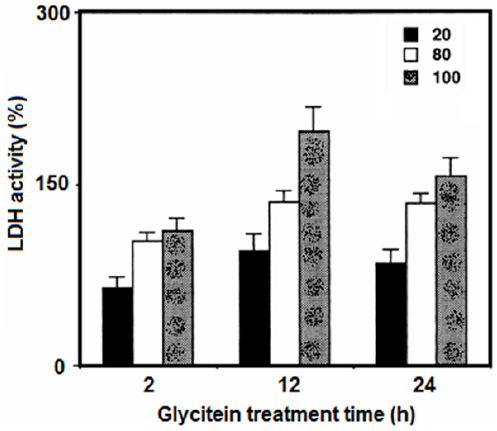
Figure 6. Cell membrane permeability of SKBR-3 cells treated with glycitein. SKBR-3cells were ex- posed to glycitein at concentrations of 20, 80, or 100 mg/mL and incubated for 2, 12, or 24 hours. Lactate dehydrogenase (LDH) activity in the cell supernatant, which correlates with cell permeability, was deter- mined as described in Materials and methods. The permeability of SKBR-3 cells treated with dimethyl- sulfoxide for the same period of time was designated 100%. Values are means ±